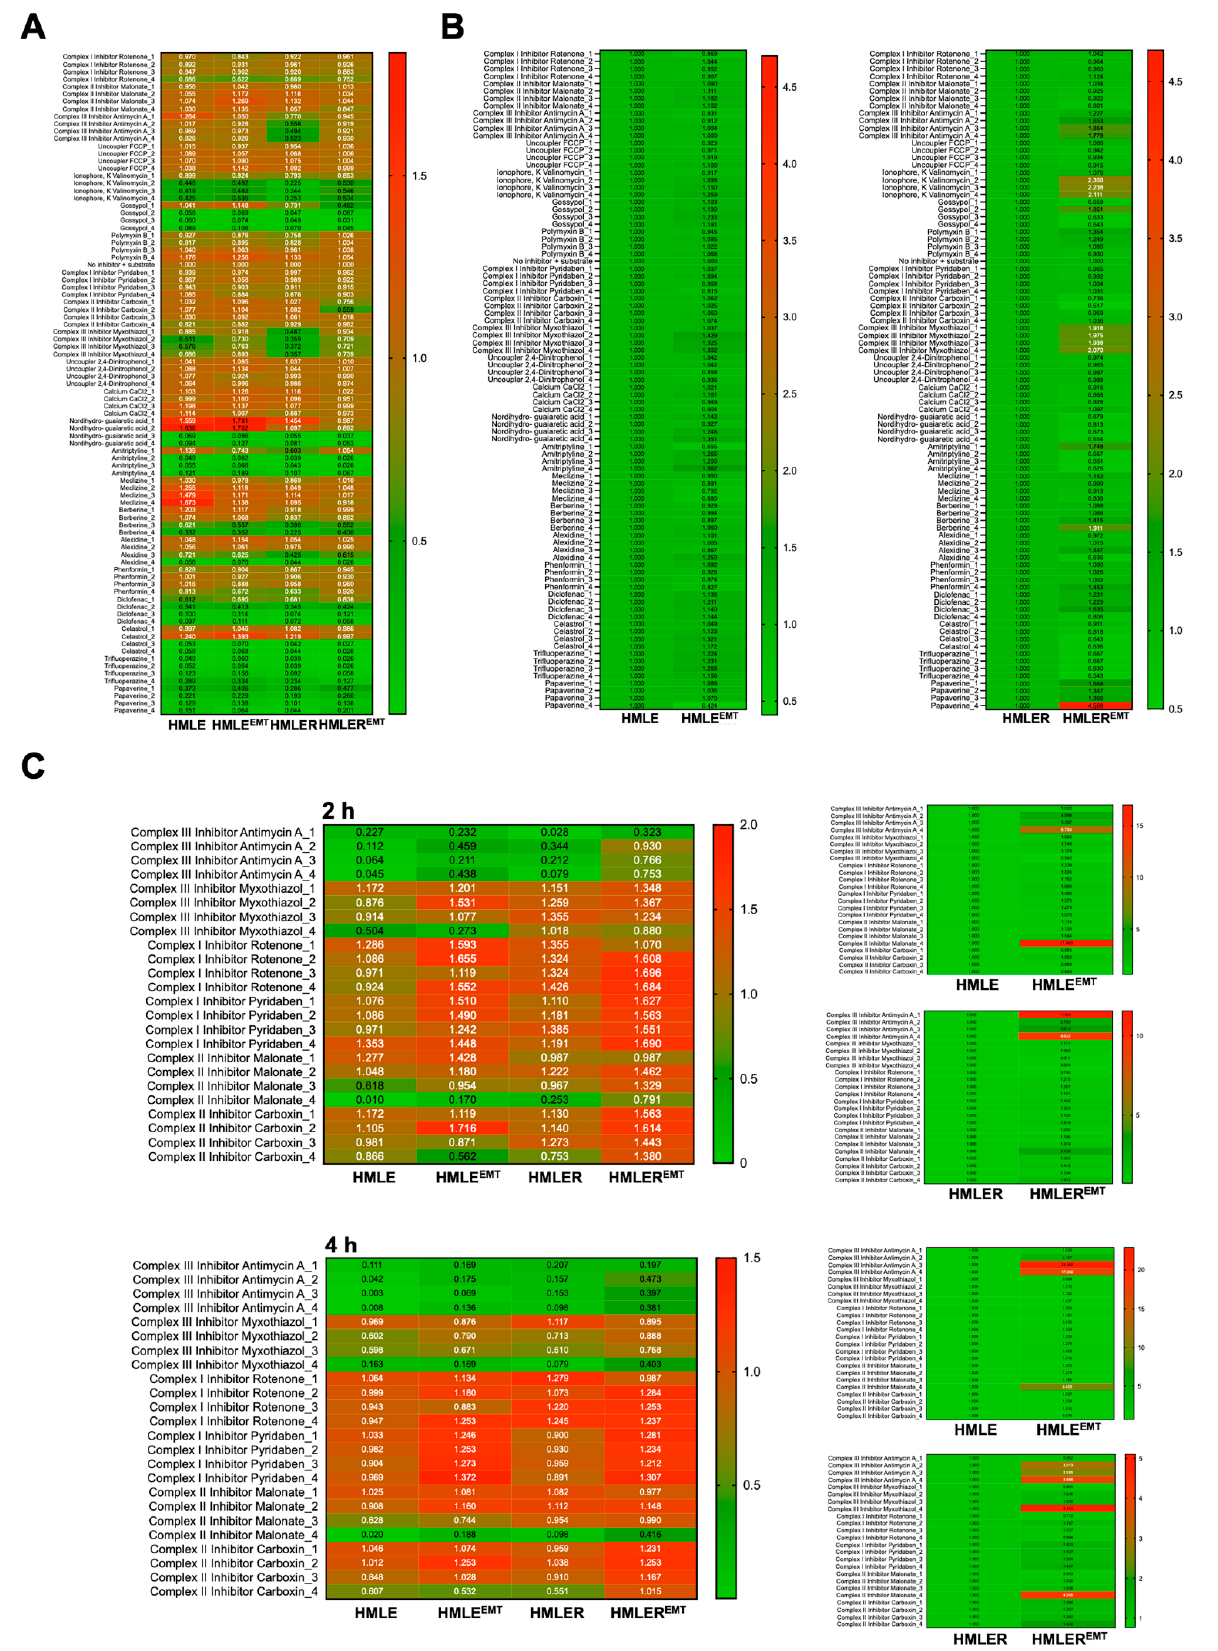
Figure 8. Responsiveness of non-tumorigenic and tumorigenic EMT to mitochondrial-centered